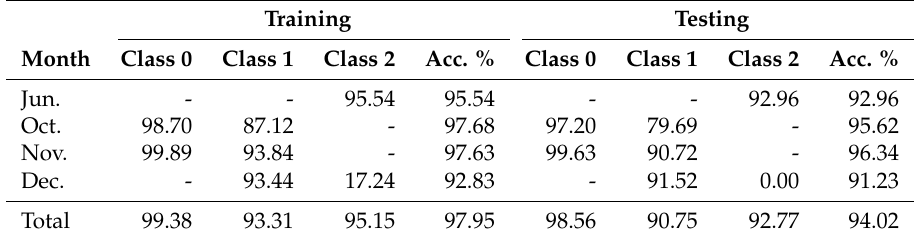
Table 7. DenseNet DBDDCA (3 class, 2 channel) monthly accuracy breakdown.